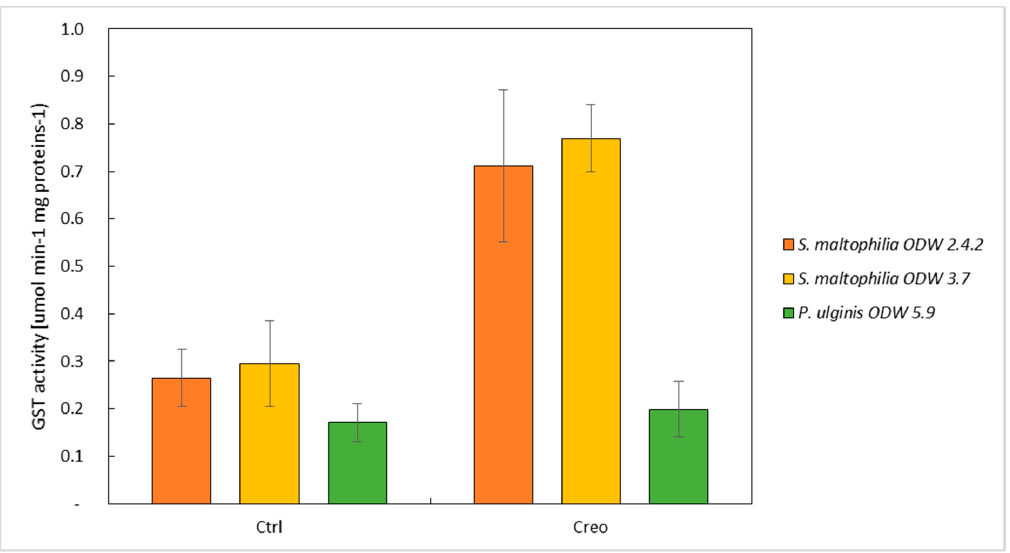
Figure 2. Activity of GST enzymes tested in three bacterial strains in control cultures (Ctrl) and the cultures with the addition of creosote oil